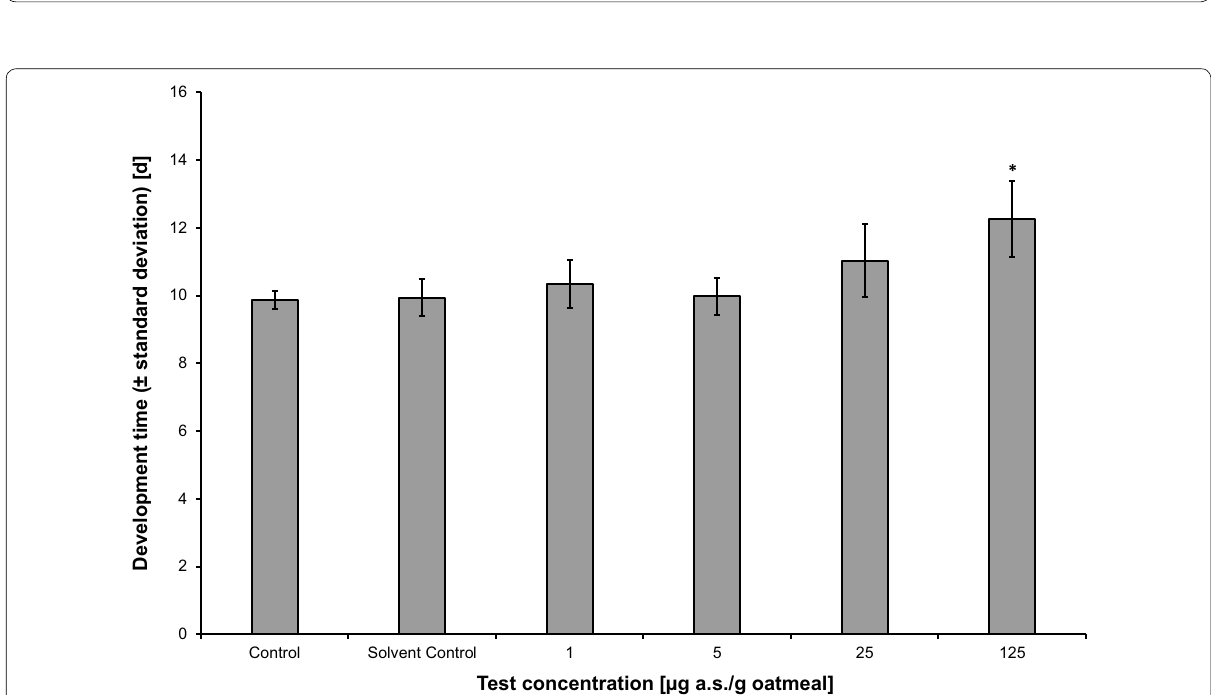
Fig. 2 Effect of neem oil (a.s. azadirachtin)-spiked oatmeal in coconut fiber substrate at 25 °C on the emergence rate ( Bradysia impatiens . *Significant difference between treatment and solvent control (Fisher’s exact binomial test with Bonferroni correction, one-sided smaller, p 0.05). a.s. active substance ≤